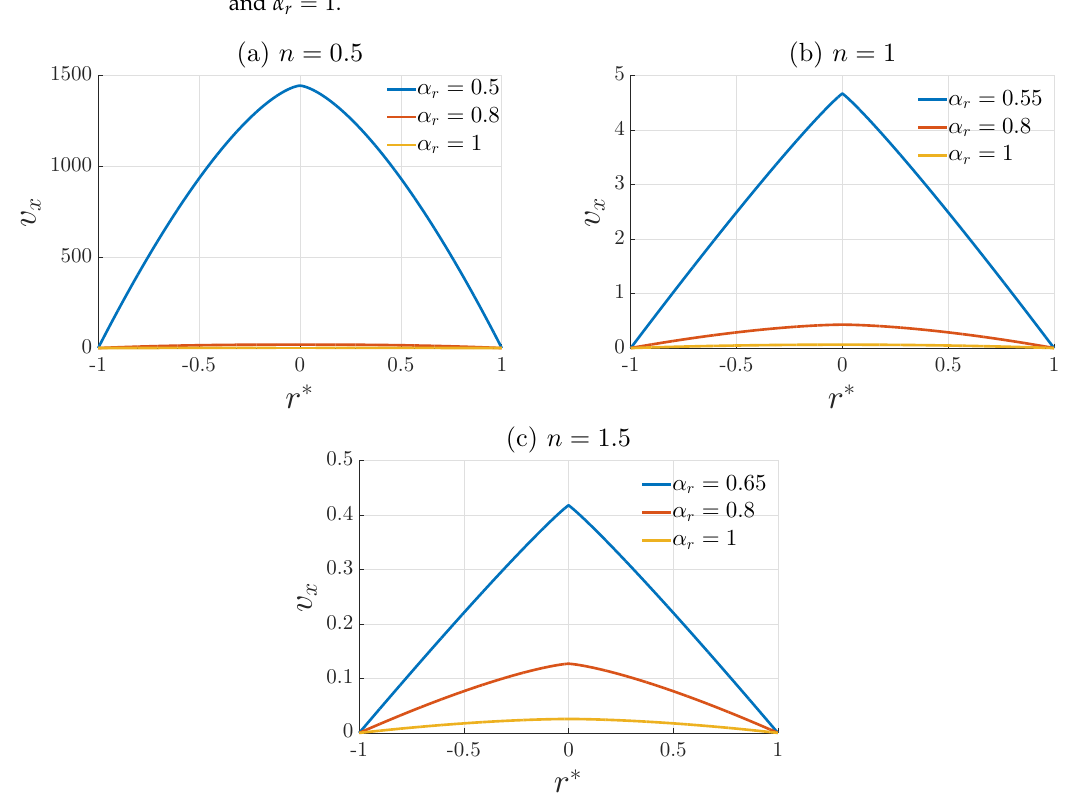
Figure 5. Plot of the profile defined by Equation (31), r ∗ = r / R , ∆ p / L = 10 Pa / m , K 0 = 10 − 3 Pa . s n and α r = 1.